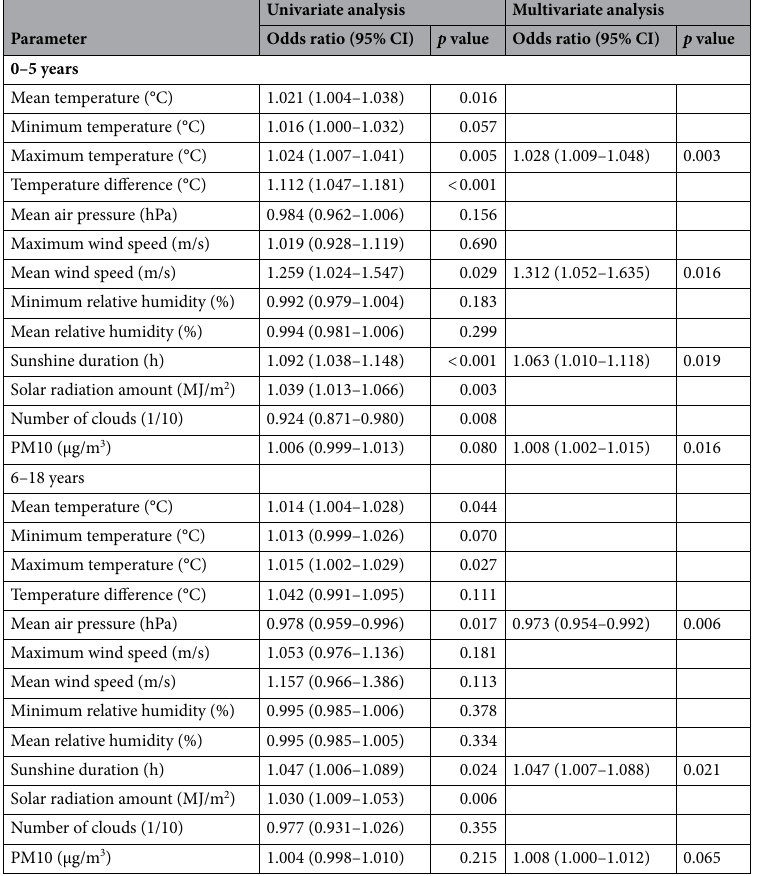
Table 3. Univariate and multivariate Poisson regression analyses of meteorological factors, including PM10 concentration and the cumulative number of hospital epistaxis presentations per day between the 0–5-